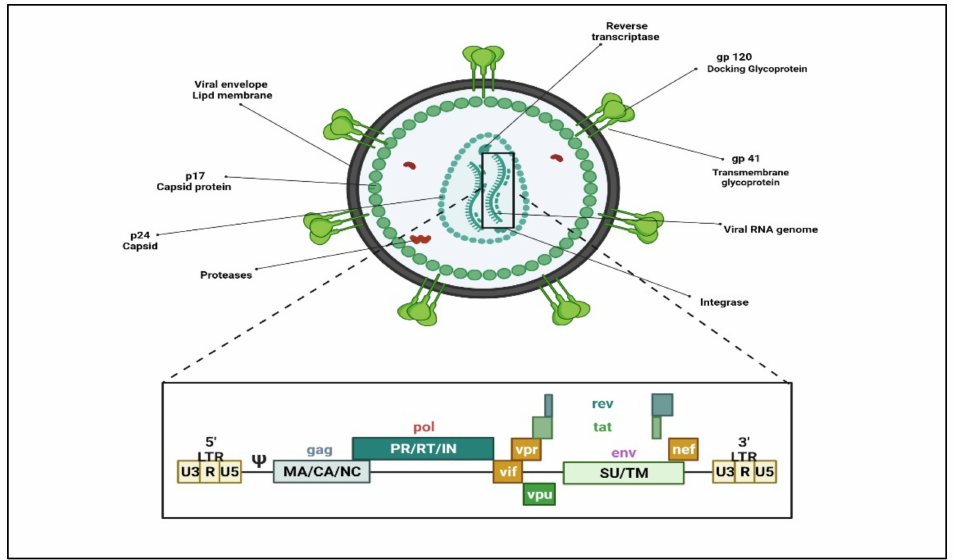
Figure 1. HIV virion structure and genome organization. (Created with BioRender.com (accessed on 19 June